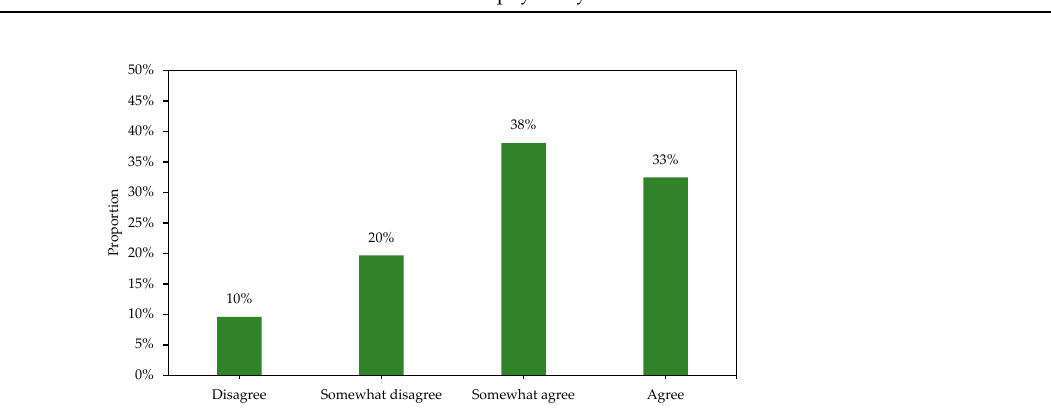
Figure 3. Distribution of proportions for the statement “I am in great need of professional development education in the area of sustainable development” for those participants who reported teaching PEH when completing the questionnaire (total sample: n = 553).